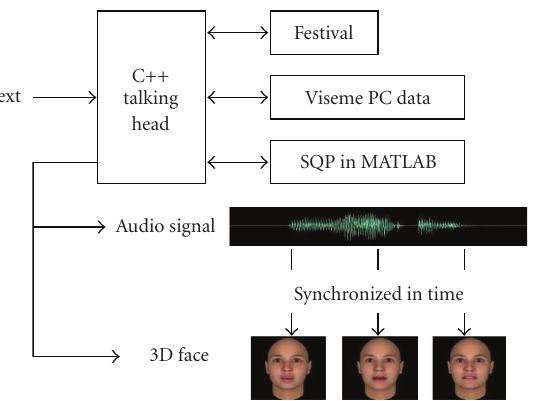
Figure 5: Talking-head